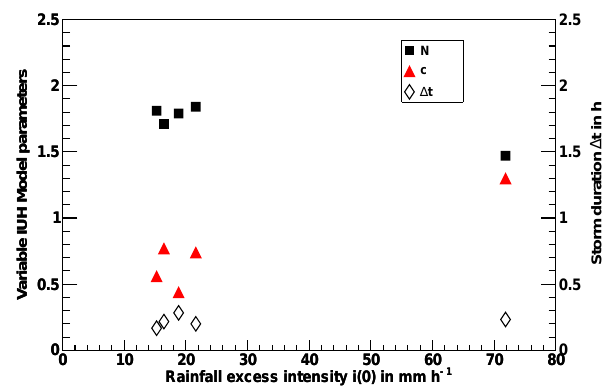
Fig. 4. Variations of the variable IUH model parameters with the causative rainfall excess intensity as calibrated for five storms on the Edwardsville, Illinois,